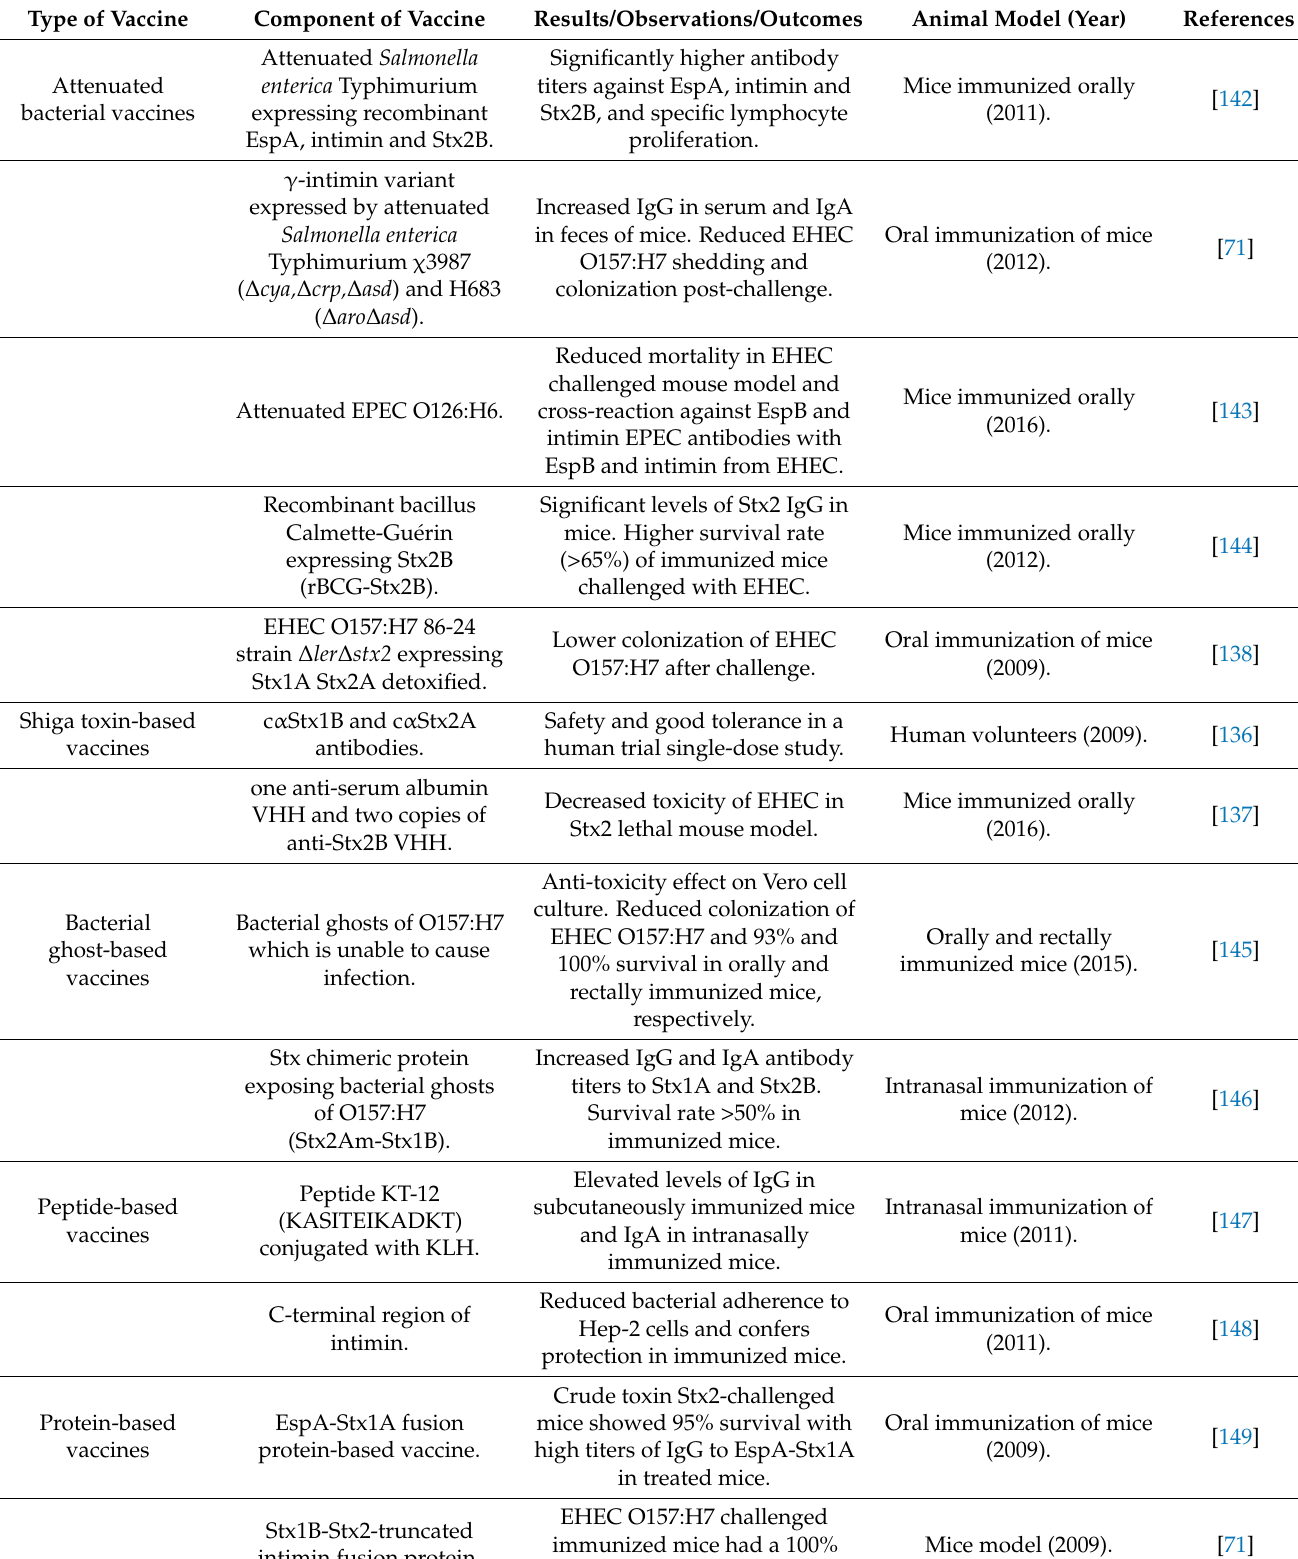
Table 2. Reports describing vaccines against Enterohemorrhagic E. coli